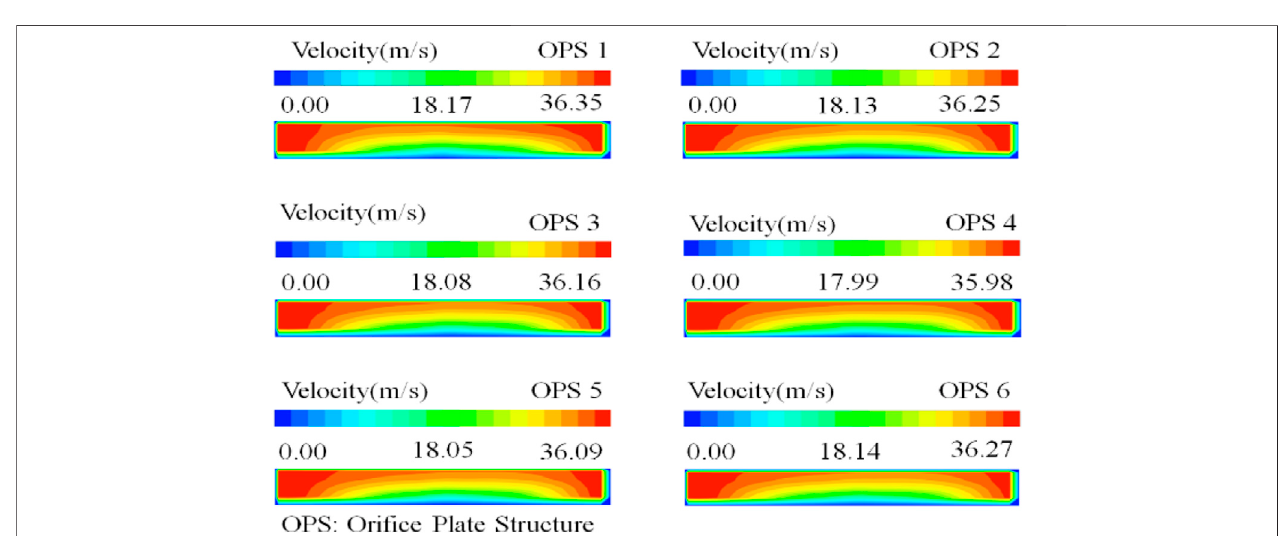
FIGURE 6 | The results of the velocity fi eld of the outlet section for six structures.